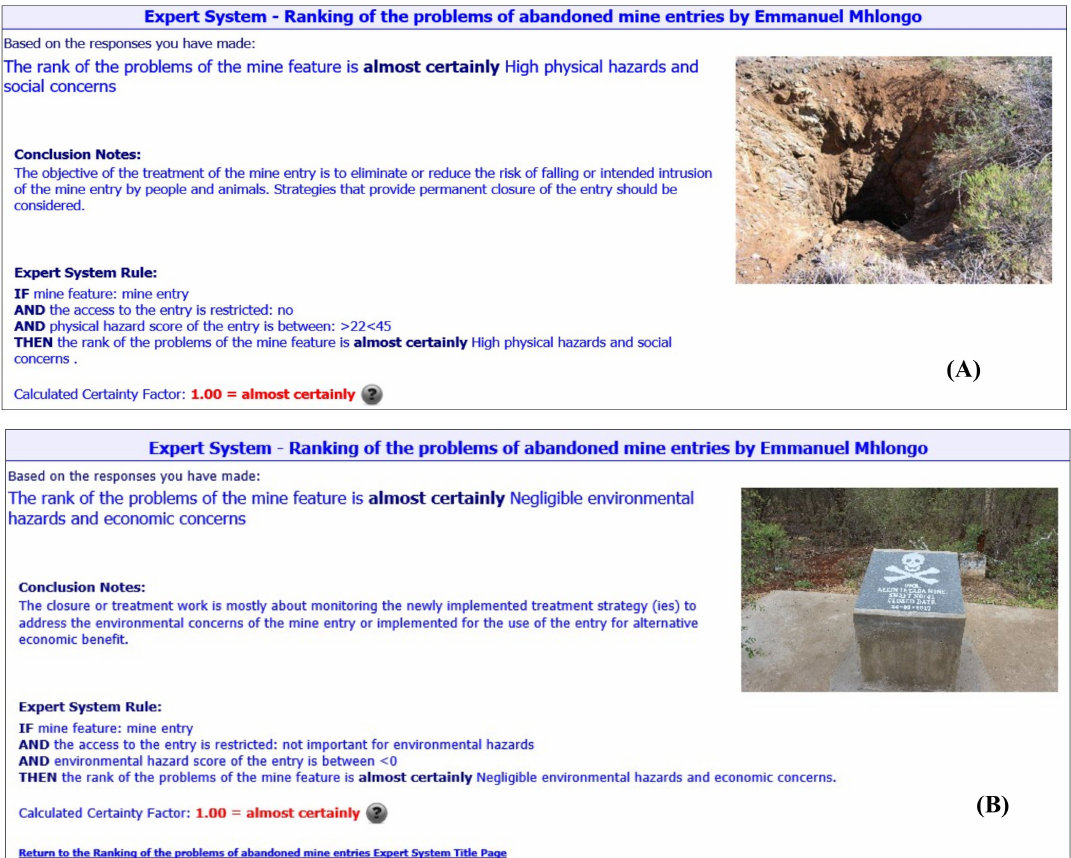
Figure 4. An illustration of the conclusion pages of the developed expert system for ranking of the problems of abandoned mine. ( A ) is the example of conclusion of the ES in high hazards mine entries and ( B ) is the example of the conclusion in the negligible hazards of the mine